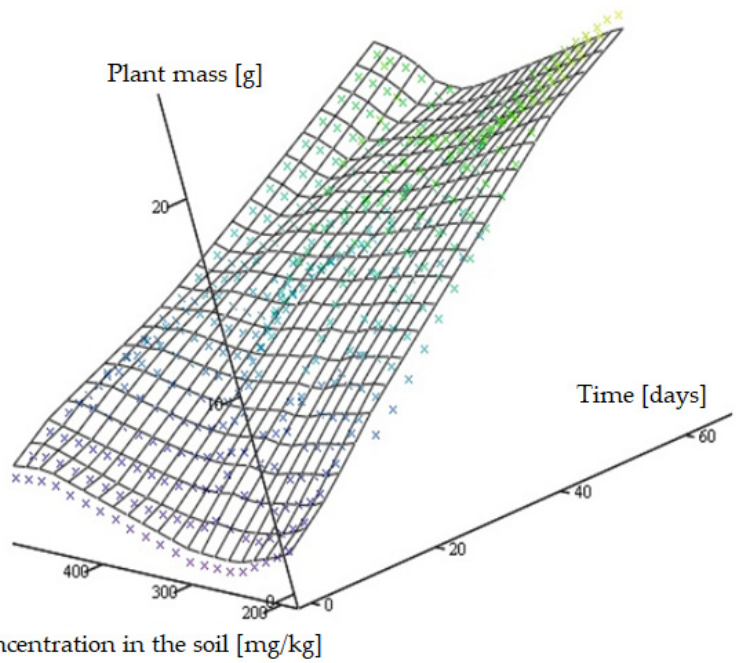
Figure 8. Variation of lettuce mass with time and the concentration of Zn in the soil, as a three- dimensional surface, corresponding to a second-degree polynomial interpolation.